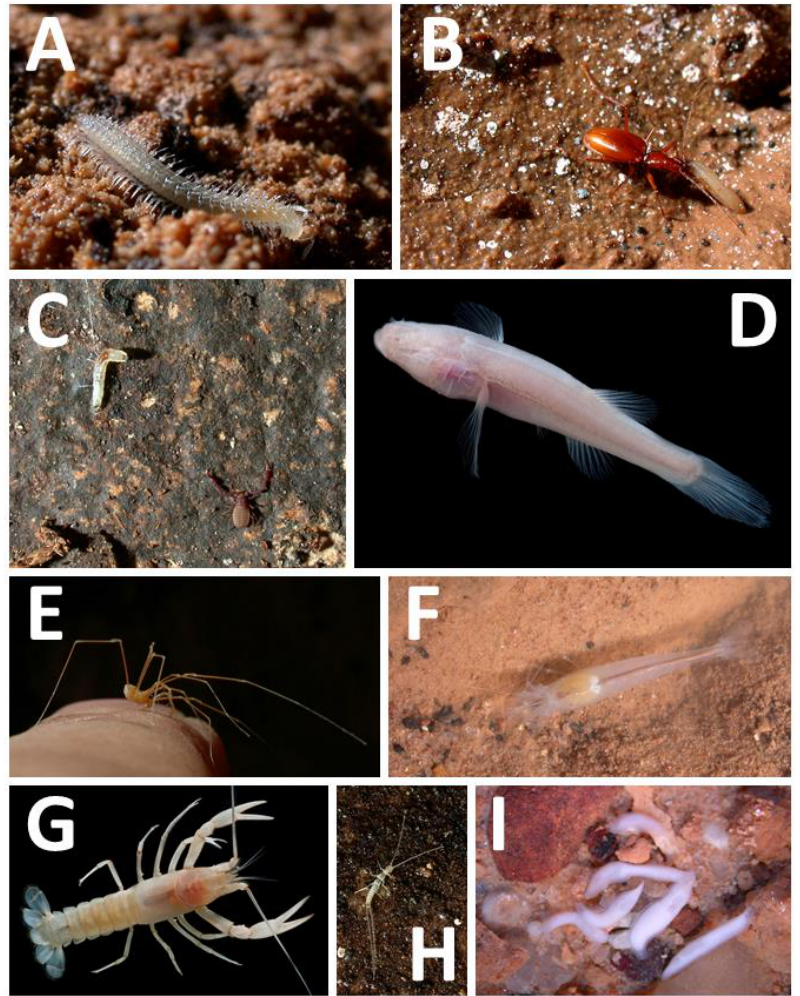
Figure 2. Representative cave-limited fauna from the Mammoth Cave System, Kentucky, USA: ( A ) Scoterpes copei (photo by Rickard A. Olson); ( B ) Neaphaenops tellkampfi feeding on the egg of the Hadenoecus subterraneus (photo by Rickard A. Olson); ( C ) Hesperochernes mirabilis with Macrocera nobilis larva (photo by Rickard A. Olson); ( D ) Amblyopsis spelaea (photo by Dante B. Fenolio); ( E ) Pha- langodes armata (photo by Rickard A. Olson); ( F ) Palaemonias ganteri (photo by Rickard A. Olson); ( G )— Orconectes pellucidus (photo by Dante B. Fenolio); ( H ) Litocampa cookei (photo by Rickard A. Olson); ( I )— Sphalloplana buchanani (photo by Rickard A.